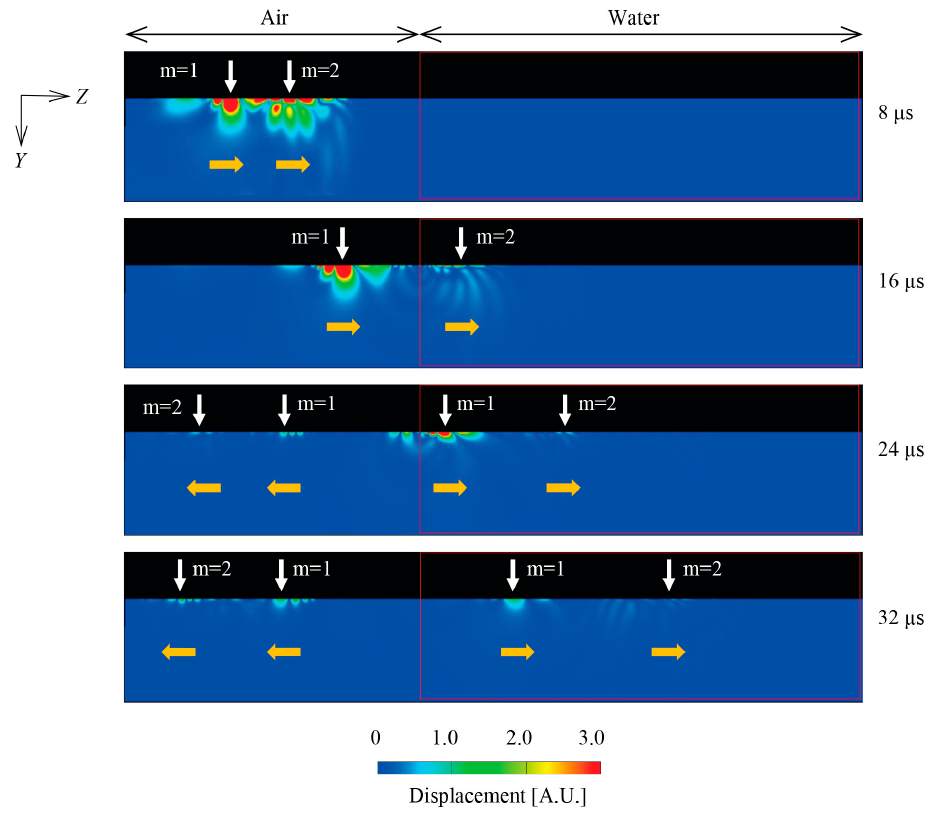
Figure 4. Simulation results of wedge wave propagating in the air. Top and side view of the waveguide is shown from 2.1 to 18.8 μ s. The colored waveform represents degrees of displacement. The faster wedge wave is mode 2 and the slower one is mode 1.